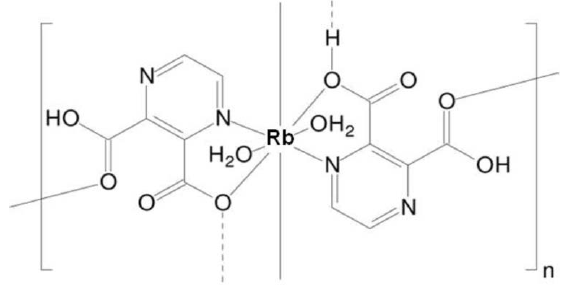
Data collection Rigaku AFC-7S diffractometer Absorption correction: numerical (Clark & Reid, 1995) T min = 0.581, T max = 0.838